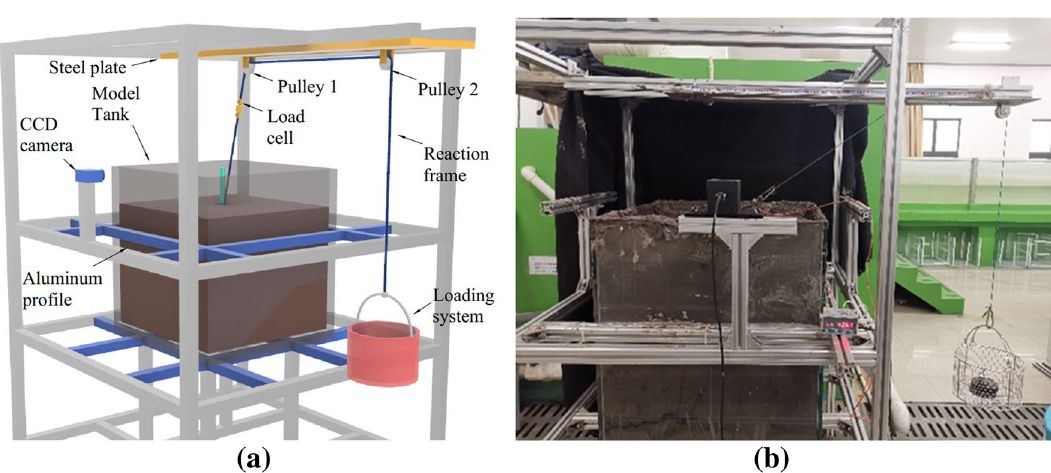
Figure 2. Schematic diagram ( a ) and photo ( b ) of the experimental